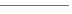
Property 5. Given a probabilistic classifier PC with structural description SD